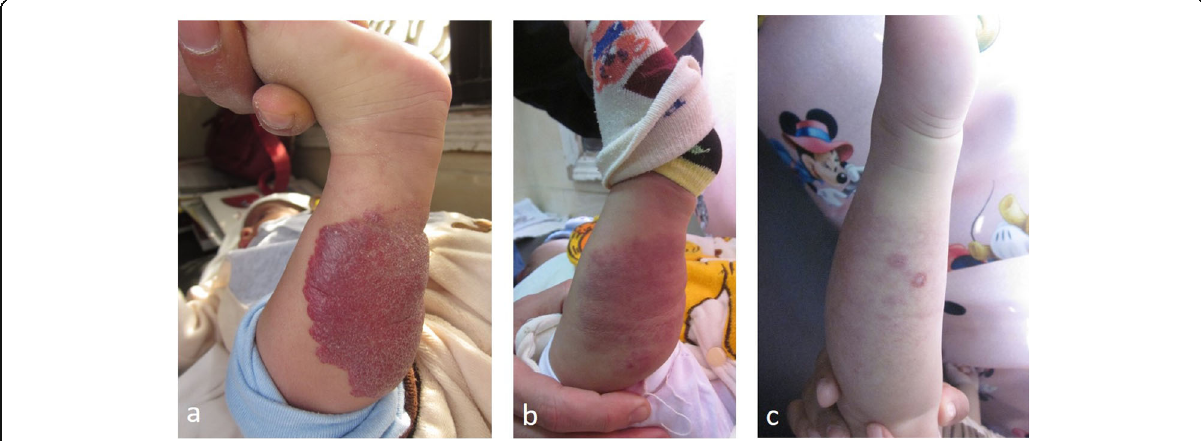
Fig. 7 Infantile haemangioma of the lower limb in the same patient at different stages showing excellent response to propranolol. a The lesion during proliferative phase at the age of 2.5 months. b The lesion at 7 months. c Haemangioma regression at the age of 12